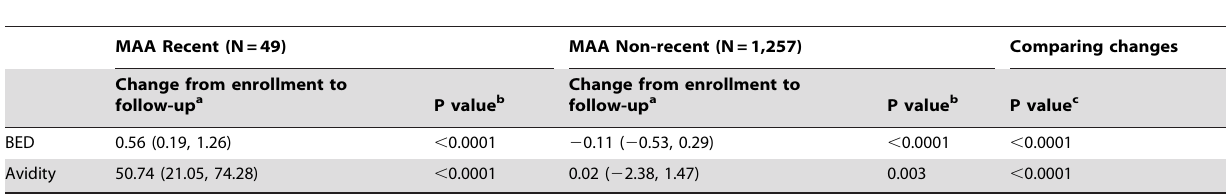
Table 2. Analysis of antibody maturation in women with MAA recent versus MAA non-recent HIV infection (paired analysis).*